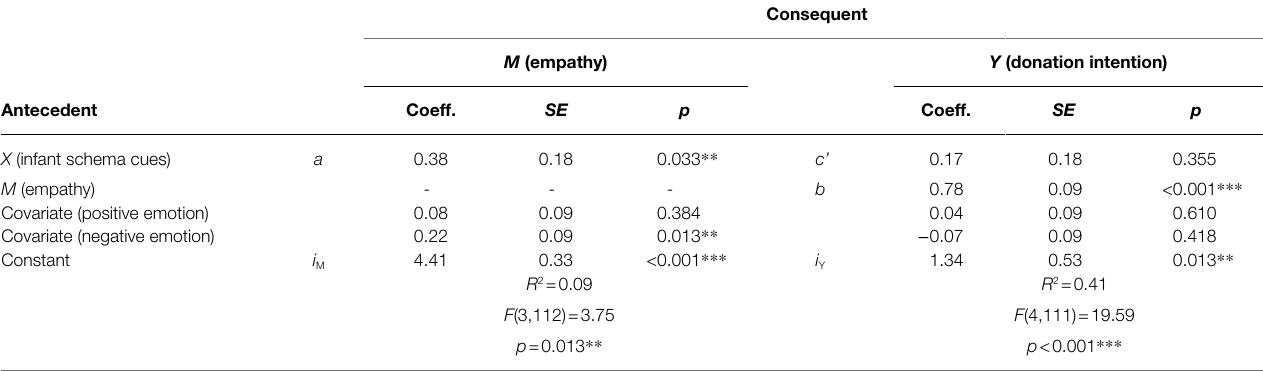
TABLE 1 | Model coefficients for the mediation model (empathy) in Study